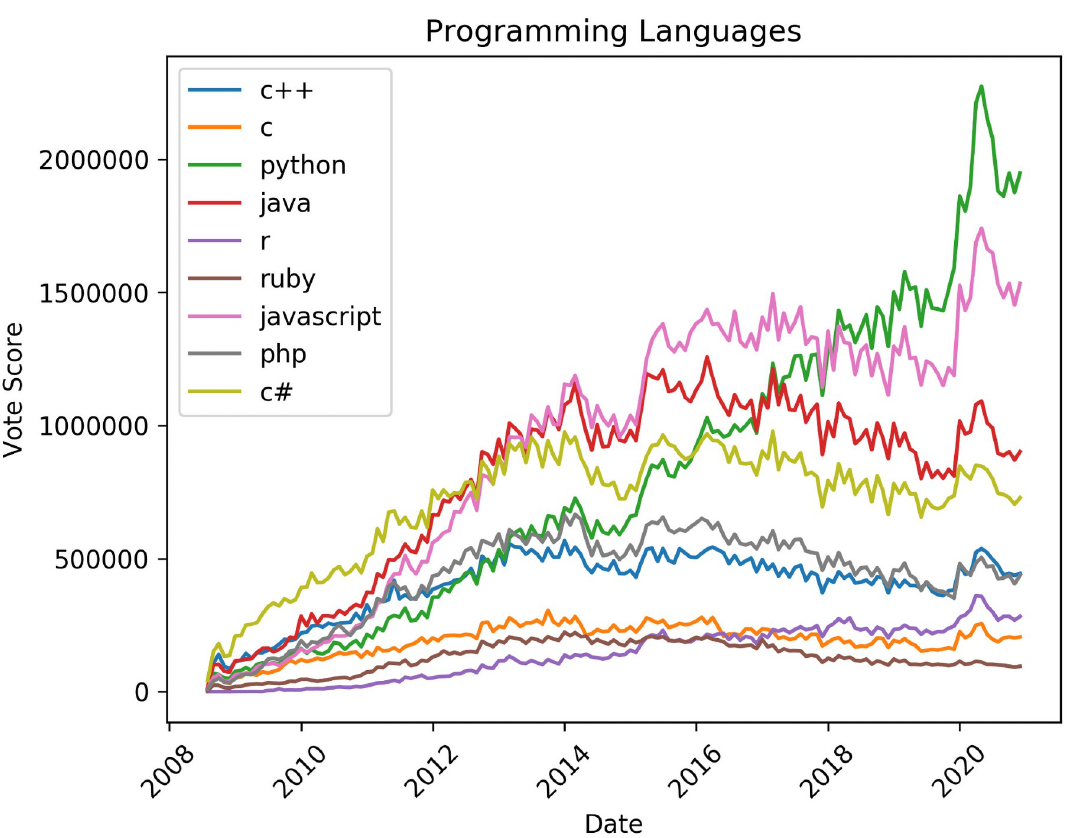
Fig 2. Trends in tag popularity: Programming